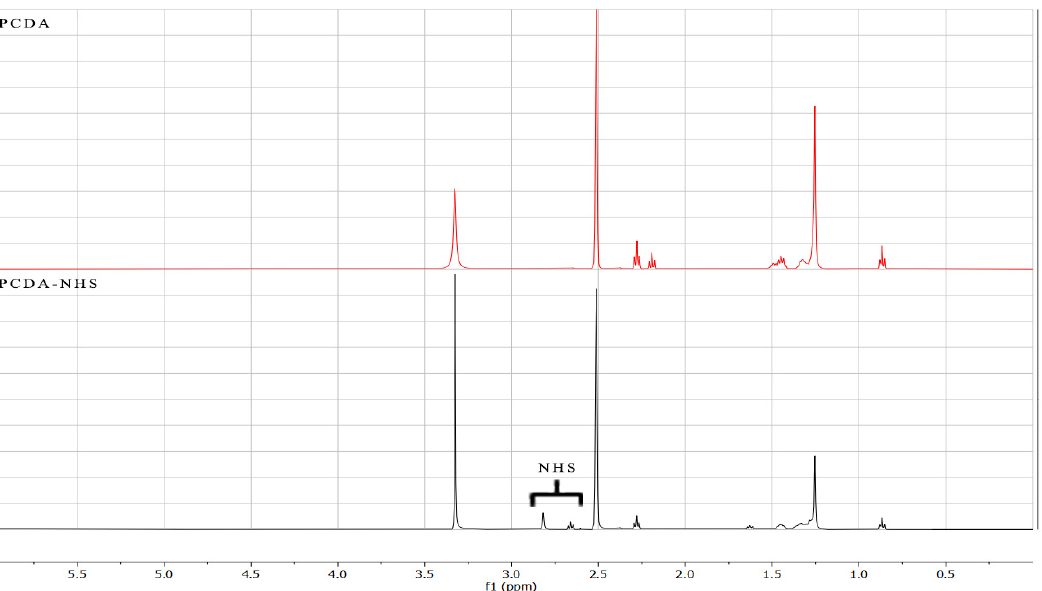
Figure 3. 1 H-NMR spectra of PCDA and PCDA-NHS. NMR spectra (500 MHz) were obtained from 3 mg of PCDA, and 3 mg of PCDA-NHS separately dissolved in DMSO-d 6 . The peak in the PCDA- NHS spectra at 2.8 ppm results from the NHS ester bond, which is not present in the spectra for PCDA.